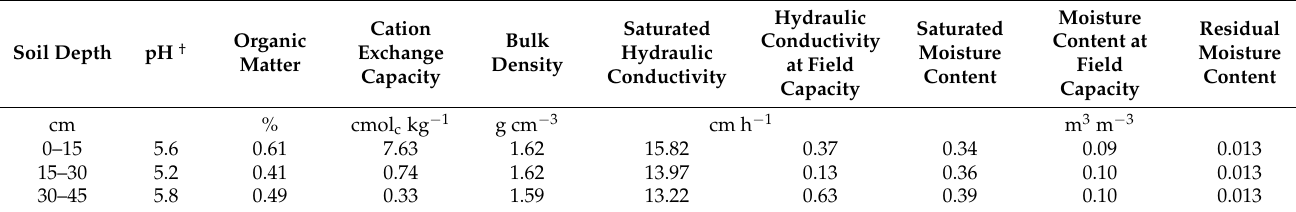
Table 1. The physical and chemical properties of the soil at the study